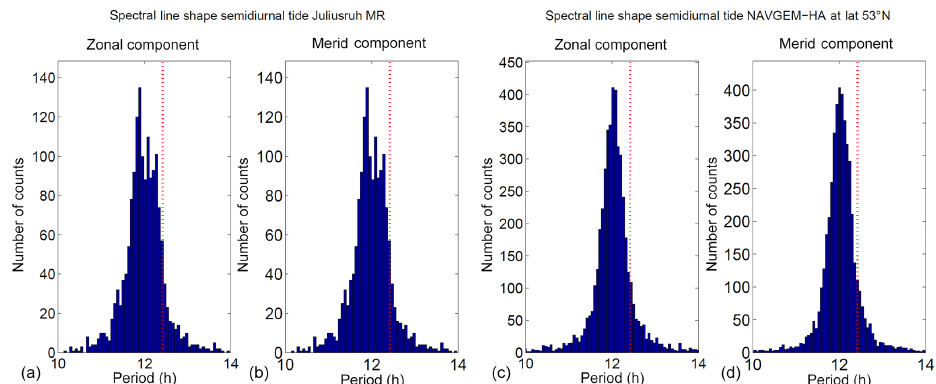
Figure 14. Histograms for the zonal and meridional frequency shift due to a temporal variable phase derived from the holograms from December 2012 to March 2013. Panels (a, b) show the local meteor radar observations at Juliusruh and panels (c, d) the global diagnostic inferred from